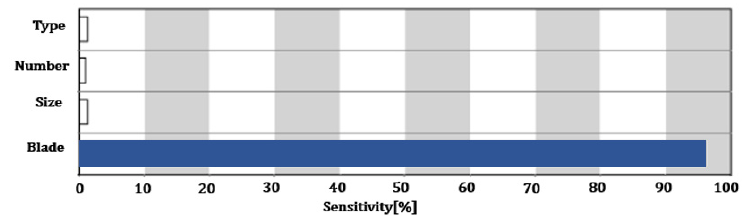
Table 5. Design variables and levels.